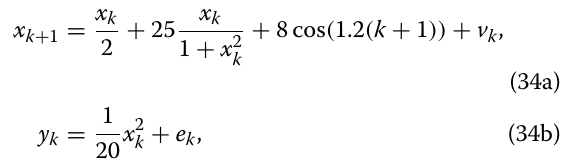
Dots in Fig. 5 illustrate the mean values as state esti- mates. Especially for the PMF, it can be seen that the mean (though optimal in a minimum variance sense [3]) is debatable for multimodal densities. Often, all estimates